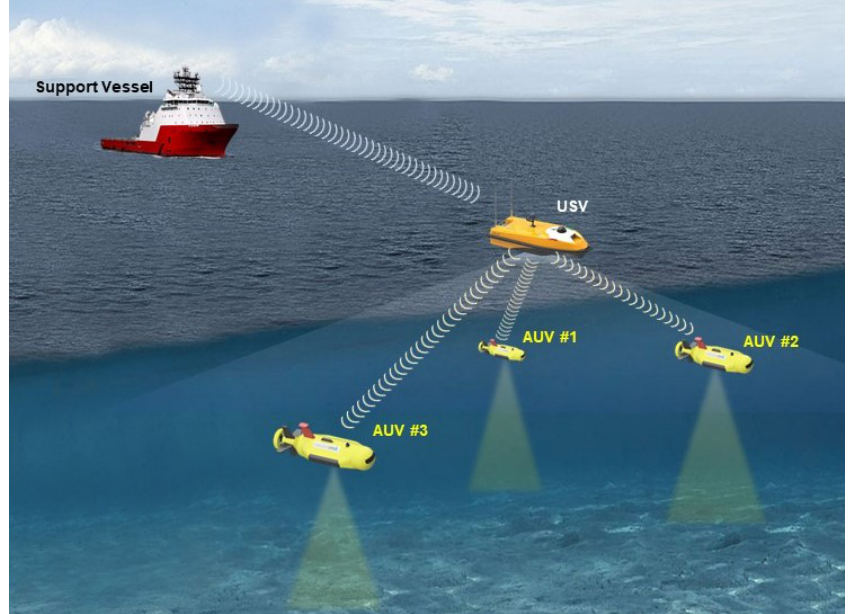
Figure 1. Star-topological acoustic communication network for a group of AUVs and a